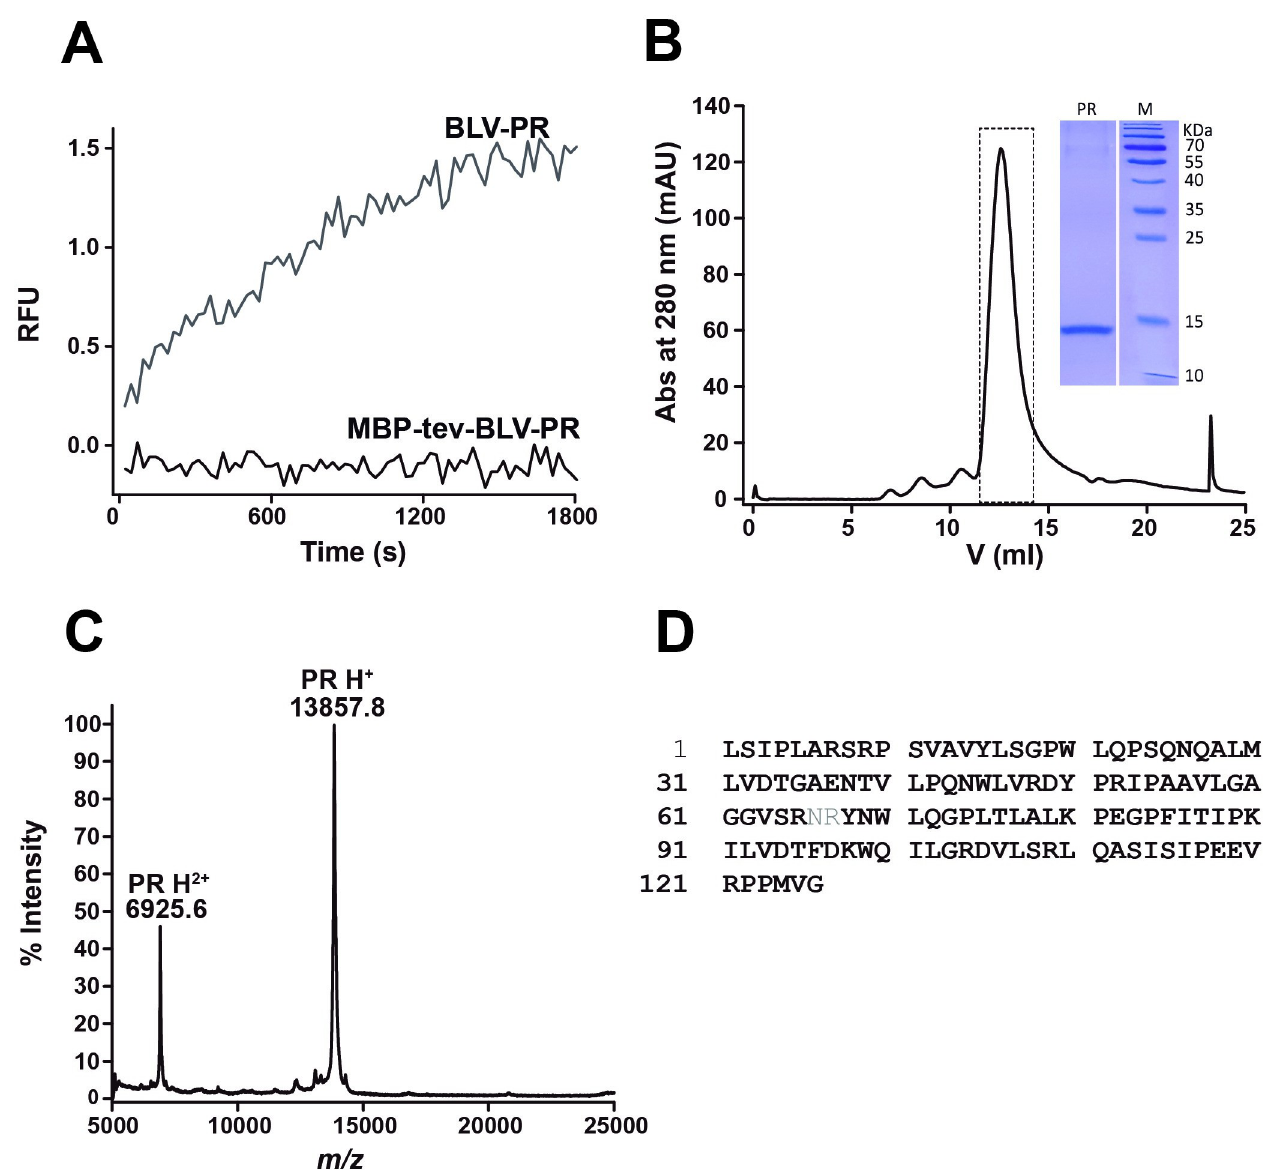
Fig 3. Activation and purification of mature BLV-PR. (A). Enzyme activity assay of the fractions eluted from the nickel affinity purification step, before and after treating with TEV (1mg each 5 mg of protein), MBP-tev-BLV-PR and BLV-PR respectively. The enzyme (1 μ L of a 1:100 dilution of the eluted fraction) was added to reaction mixtures containing the fluorogenic substrate (MA-CA, 5 μ M) in reaction buffer. (B). Final purification step by size exclusion chromatography using Superdex 75 10/300 column previously equilibrated with Tris (50 mM, pH 8.0, 100 mM NaCl). The inset shows the SDS-PAGE analysis of the fraction collected. (C). MALDI-TOF MS of purified BLV-PR. The peak at m/z 13857.8 Da matched the MH + value predicted for BLV-PR (13871.5 Da). (D) Observed coverage (98%) of the peptide mapping of BLV-PR treated with trypsin by mass spectrometry, the identified residues are highlighted in